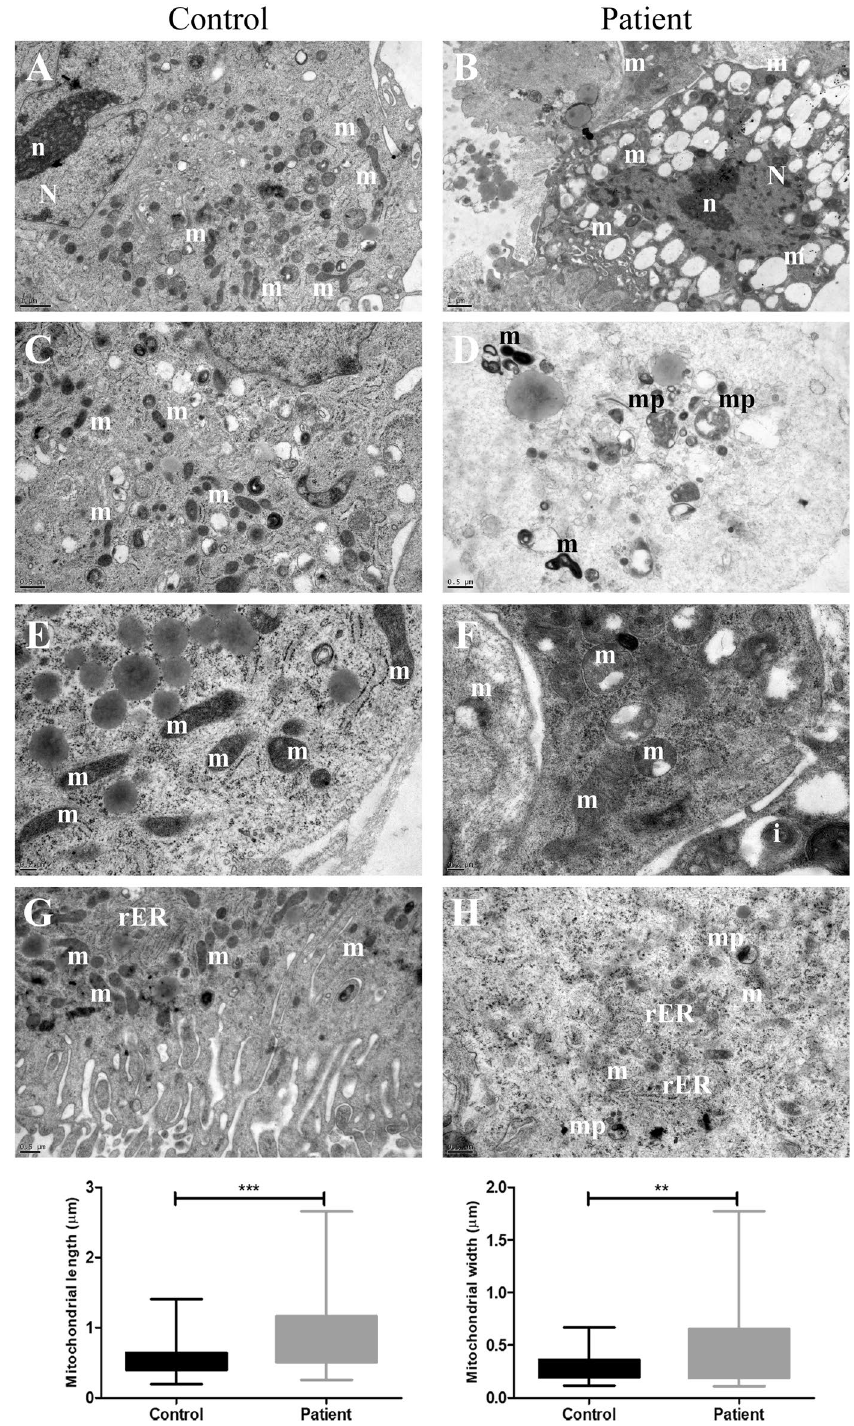
Figure 3. Transmission electron microscopy analysis of the differentiated Megaconial CMD myotubes. The electron micrographs of the control ( A , C , E , G ) and the patient ( B , D , F , H ). Note the abundant and pleomorphic, giant mitochondria in the patient’s sample. Mitochondria contain vacuoles and/or electron dense globular inclusions in ( D , F , H ). Giant, degenerated mitochondria present abnormal cristae and condensed structure in ( B , D , F , H ). Nucleus appears healthy in ( A ) and ( B ). ( G ) and ( H ) presents rough endoplasmic reticulum cisternae next to mitochondria. Uranyl acetate, lead citrate. N: Nucleus, n: Nucleolus, m: Mitochondria, i: Inclusion, mp: Mitophagic Vacuoles, rER: Rough Endoplasmic Reticulum. ( A ) 15,000×, ( B ) 12,000×, ( C , D ) 25,000×, ( E , F ) 40,000×, ( G ) 20,000×, ( H ) 25,000×. The graphs in the lower panel present median, min., max., values of the mitochondrial length and width for the patient and control myotubes. ** p < 0.01, *** p < 0.001. Measurements were conducted using at least 50 mitochondria in both patient and control